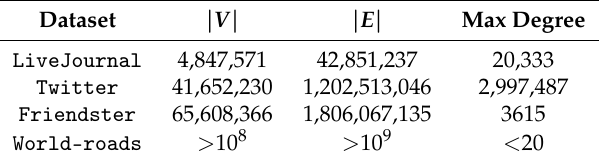
Table 1. Statistics about datasets used. (Numbers for World-roads are